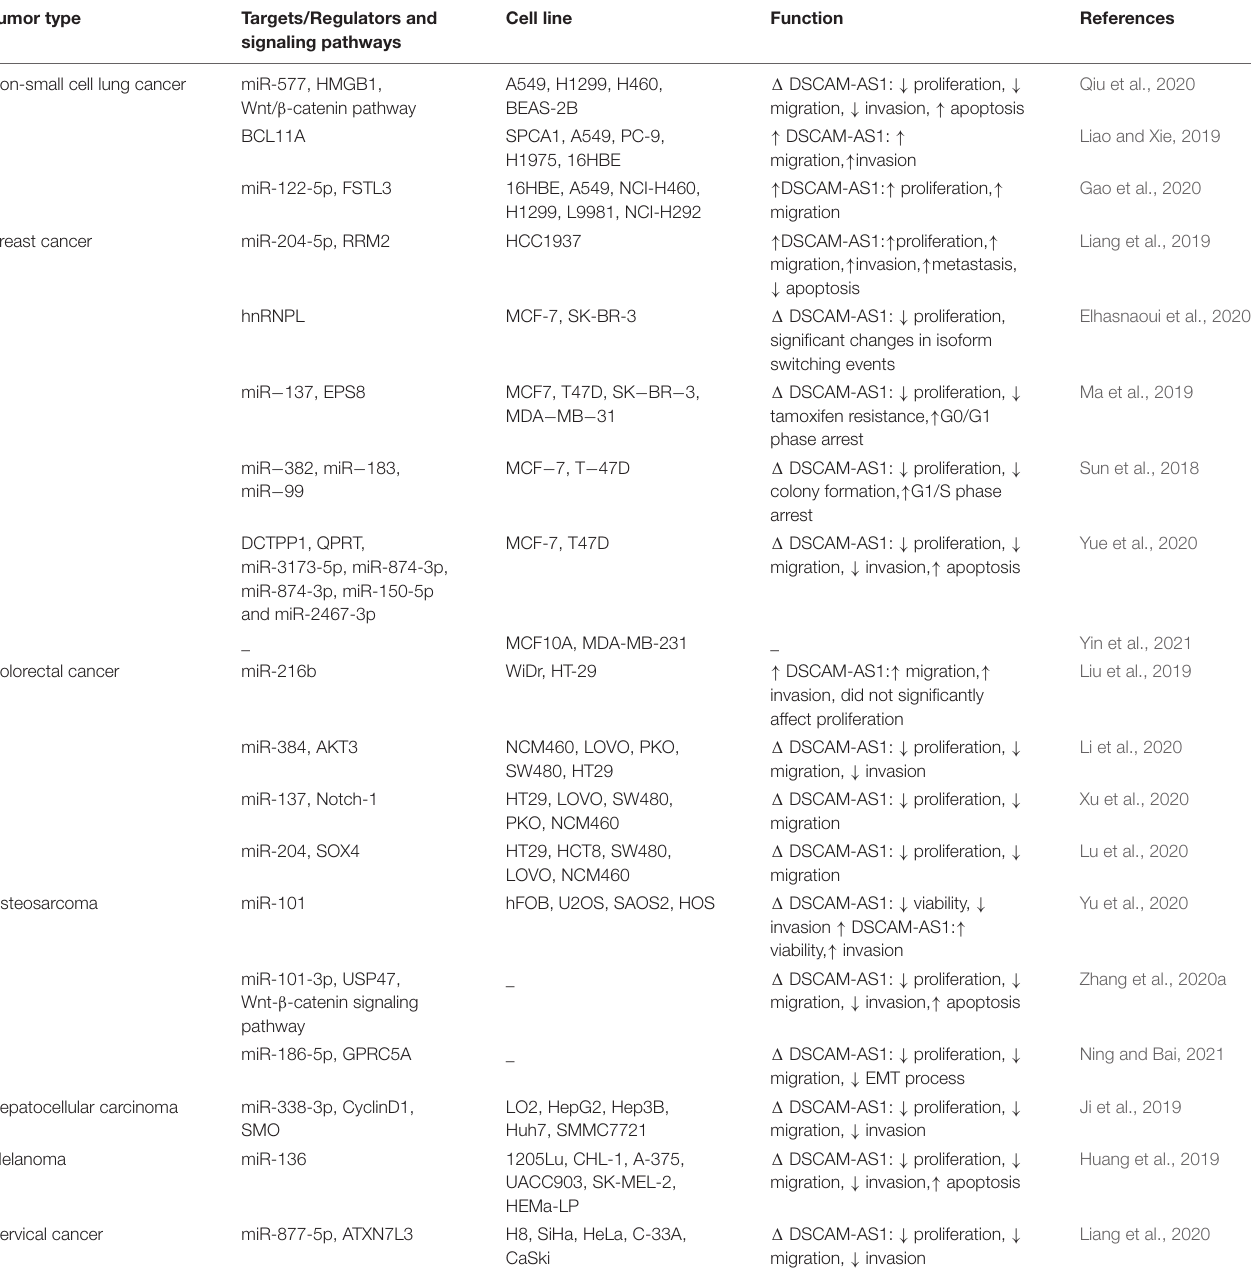
TABLE 1 | Outlines of researches which judged expression of DSCAM-AS1 in cell lines ( (cid:49) : knock-down or